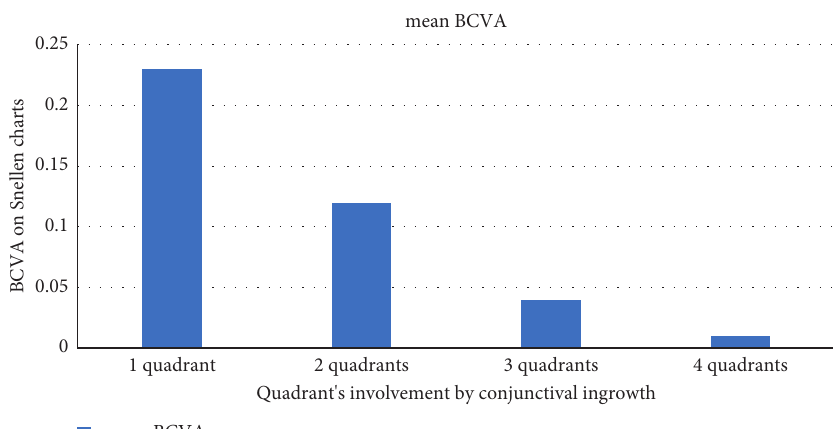
Figure 5: Mean visual acuity obtained by patients depending on the degree of conjunctival recurrence in the consecutive corneal quadrants.